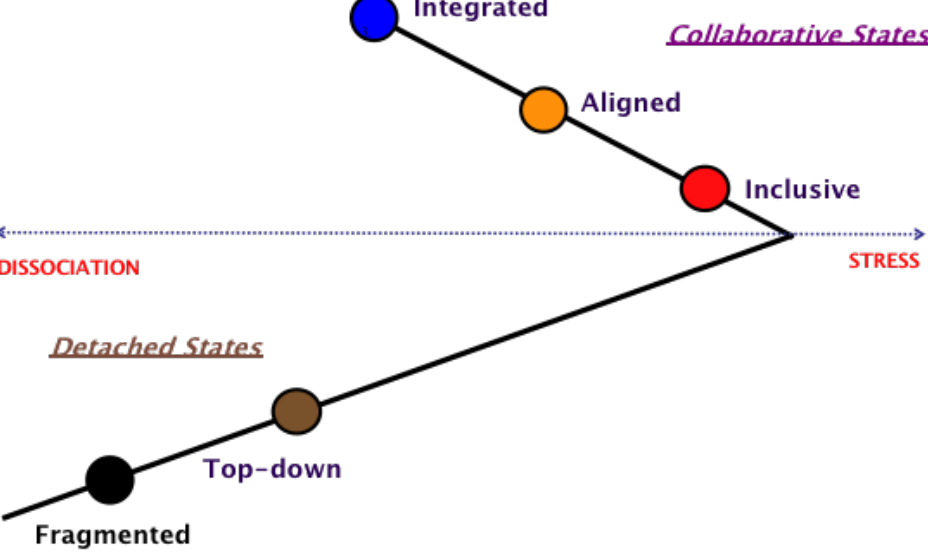
Figure 4. Two-dimensional representation of the fundamental change from collaborative to detached.